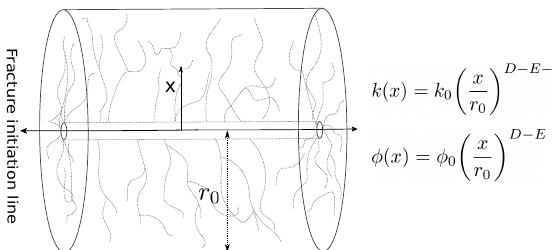
Figure 4. The fractures, represented by the dotted lines, initiate at the center of the cylinder and follow a branching pattern, spreading through the rock. Away from the center, density of the branched fractures decreases following a power law, as do the fracture porosity, φ , and fracture permeability, k . In the equation, D is the fractal dimension, E is the Euclidean dimension ( E = 1 for one fracture; E = 2 for more fractures), and θ is the tortuosity index of the fracture network. Adapted from